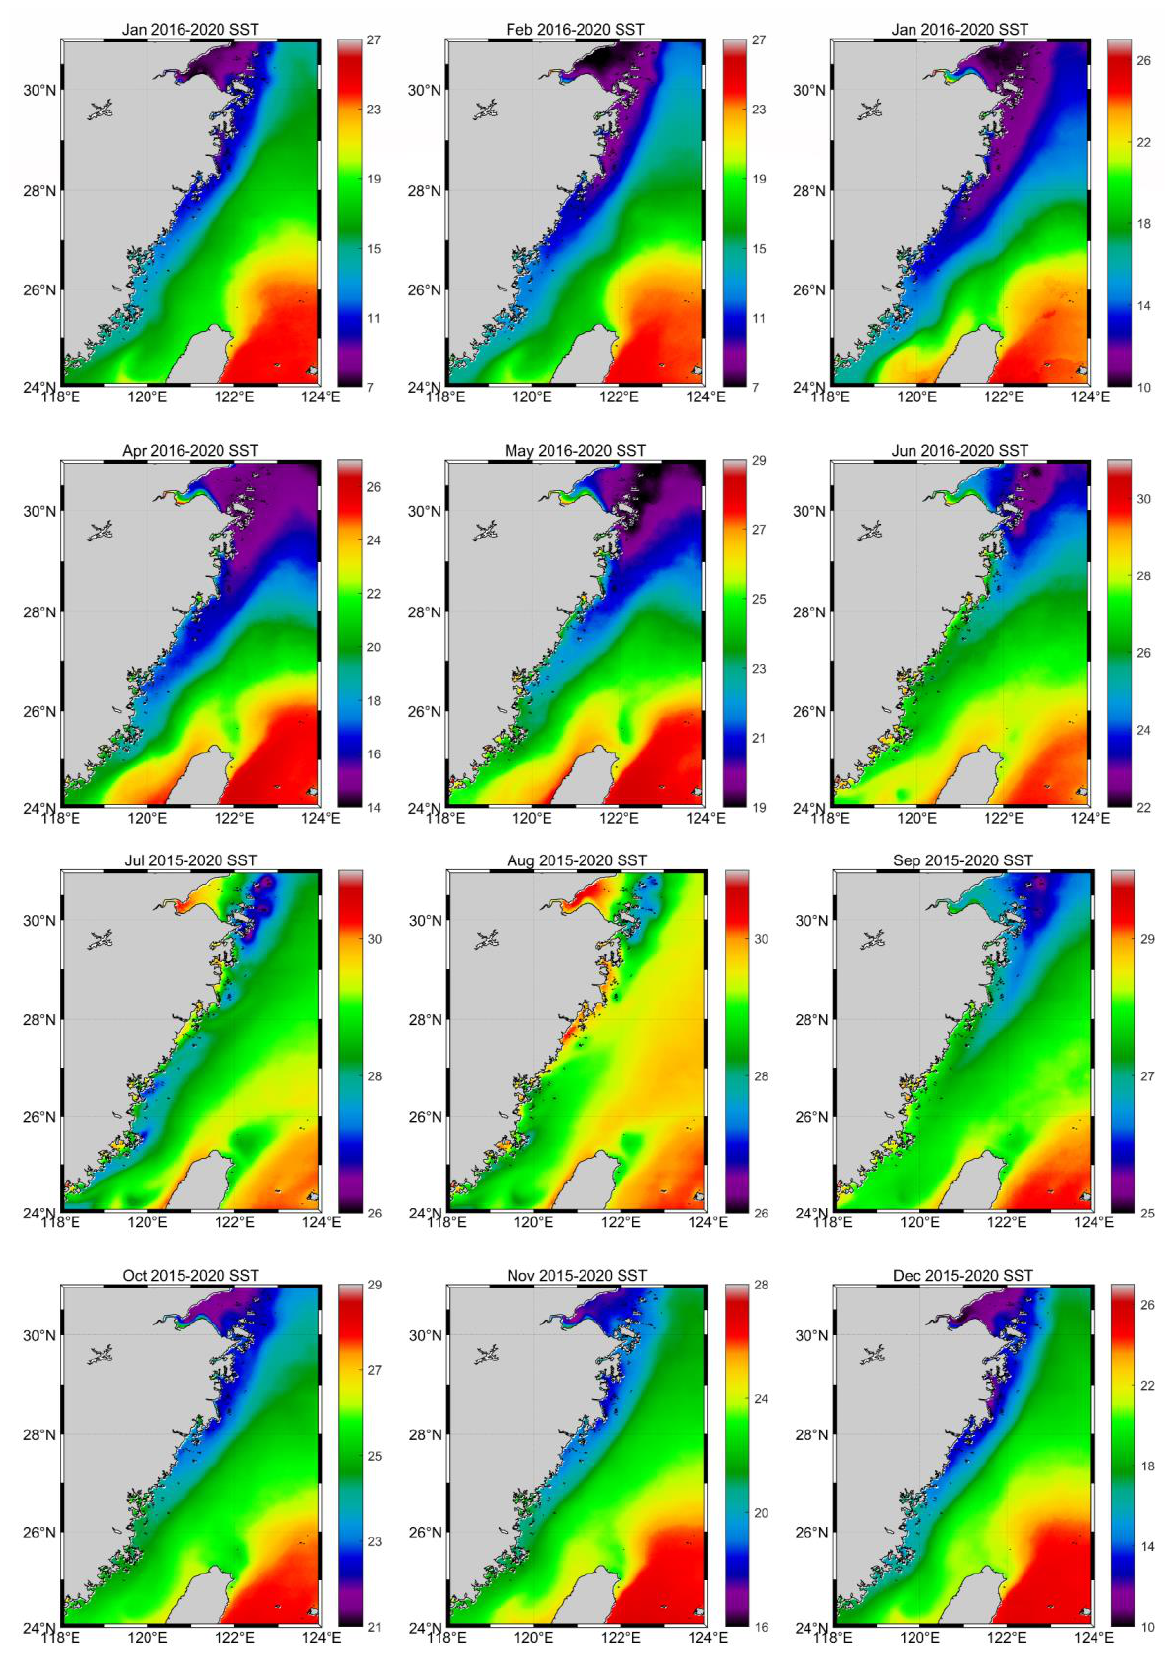
Figure 4. Long-term (2015 – 2020) mean monthly maps of SST (°C). Color scales are adjusted monthly.